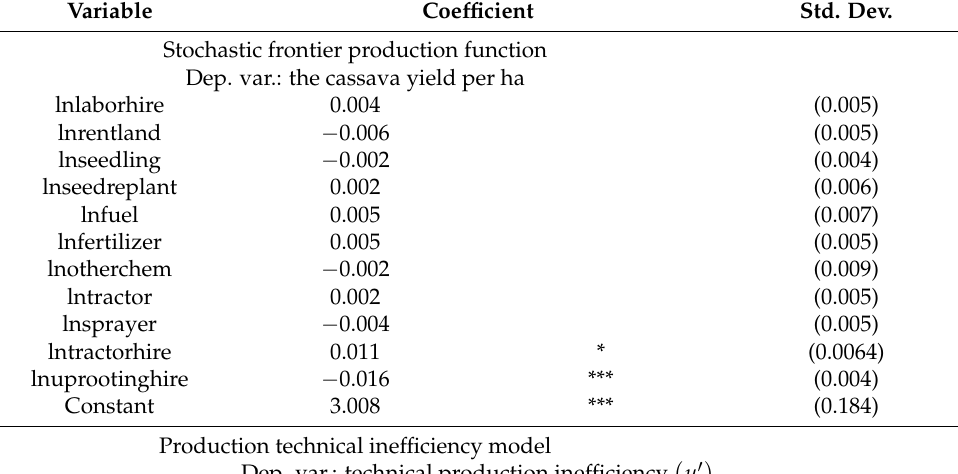
Table 2. Estimated parameters for the cassava yield per hectare using the stochastic frontier produc- tion function. Variable Coefficient Std. Dev. Stochastic frontier production function Dep. var.: the cassava yield per ha